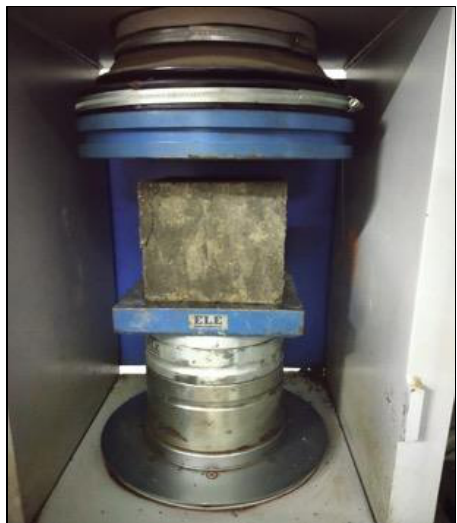
Fig. 3. Testing at compressive testing